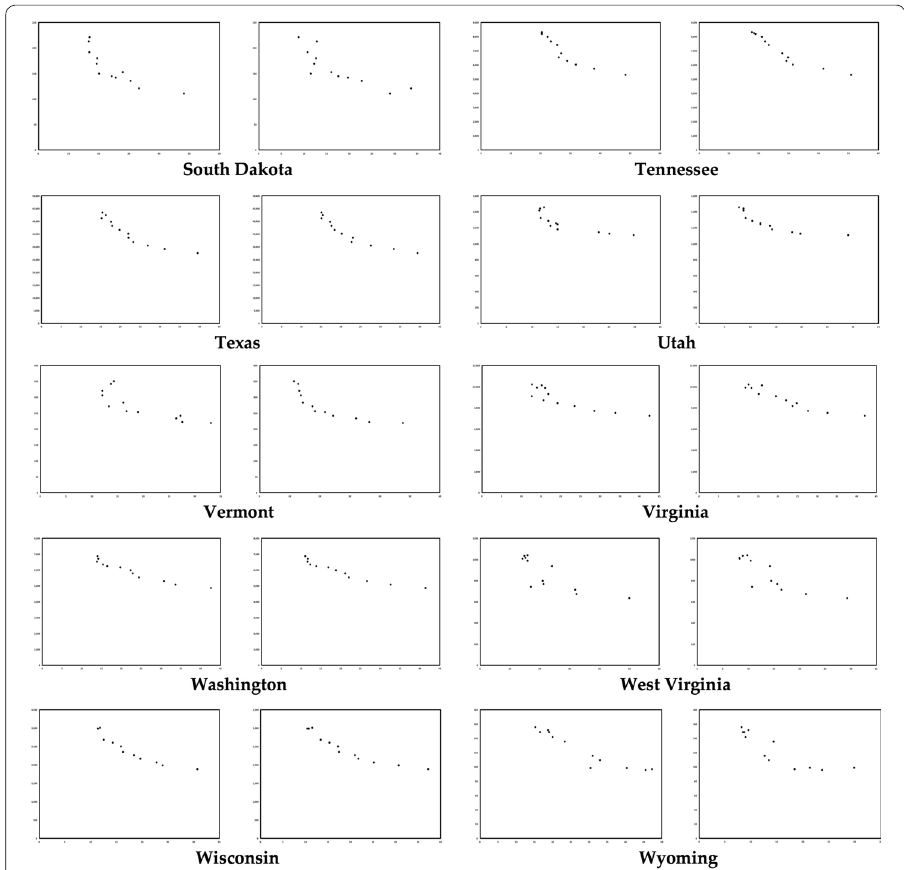
Fig. 7 ‘AIDS Prevalence’ vs. Google Trends ‘AIDS (Search Term)’ and ‘AIDS (Illness)’ from January 2004 to December 2015 (South